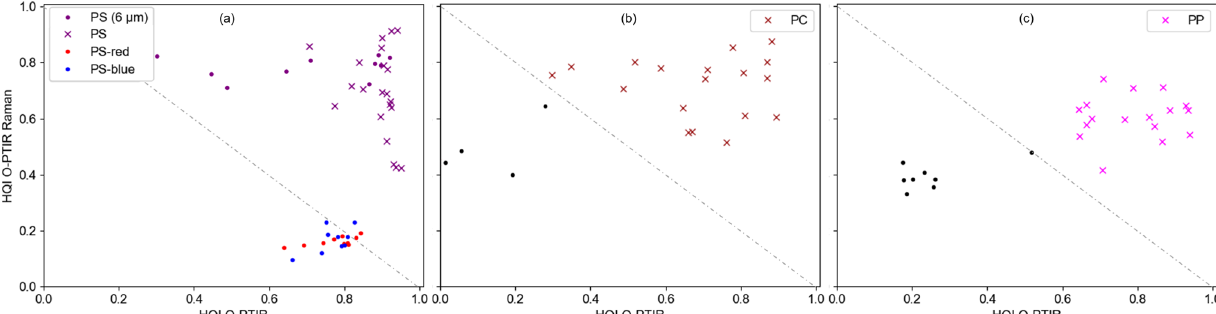
Figure 6:. 2D-HQI of different microplastic particles from simultaneous O-PTIR and Raman acquisition with reference spectra. HQI of transparent, irregular-shaped PS (x), transparent PS beads (6 µm) (o) and colored PS beads (10 µm) (o) ( a ); irregular-shaped PC ( b ); and irregular-shaped PP ( c ). Black dots: putative contaminations with both low O-PTIR and Raman